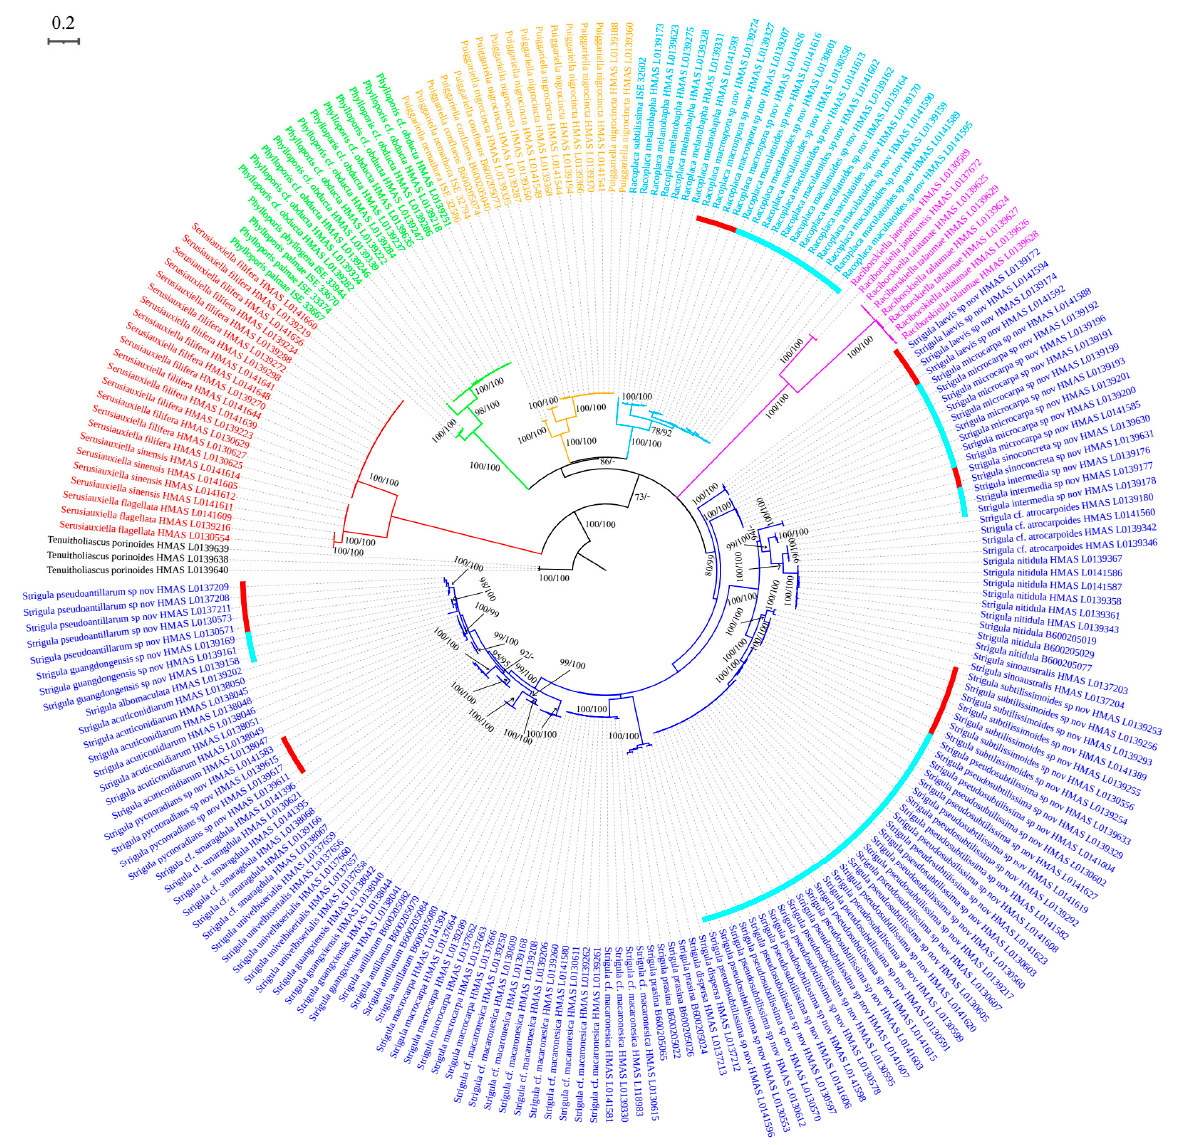
Figure 1. Phylogenetic tree constructed through ML analyses based on 225 ITS sequences with an alignment length of 448 bp. Bootstrap values above 70% ( left ) and Bayesian inference posterior probabilities above 95% ( right ) are given above branches (ML ‐ BS/B ‐ PP). Newly recognised species are marked with red or blue stripes.